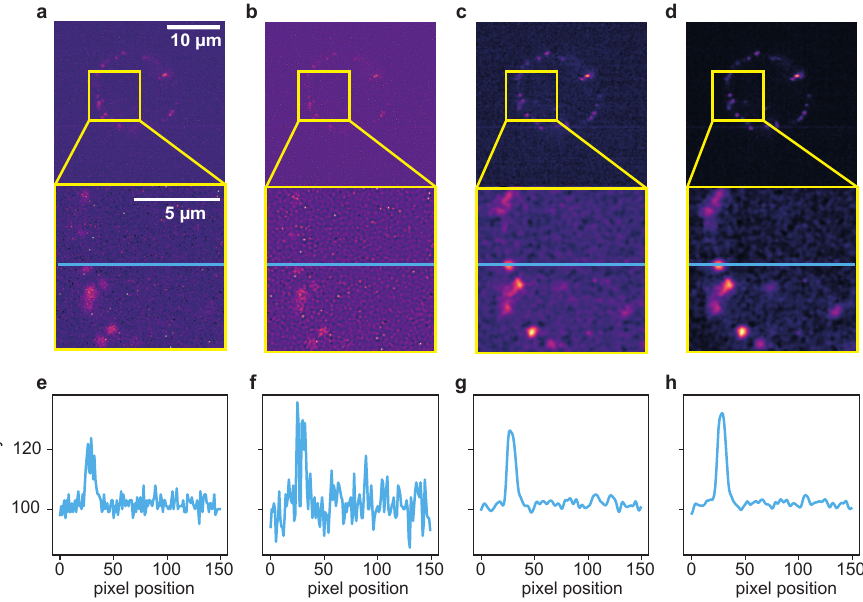
Figure 4. Comparison of the different deconvolution methods for a time series of dataset 2, captured at 100 ms exposure time. ( a ) Raw image. ( b ) Deconvolved with the MATLAB Lucy–Richardson algorithm. ( c ) Deconvolved by ER with λ = 2.0. ( d ) Deconvolved with the proposed TD ER with ( λ = 2.0, λ T = 2.0). Each panel includes a zoomed-in region of interest indicated in yellow. ( e – h ) The intensity profile plotted along the blue line in the frames above. All entropy-based algorithms here use ε =